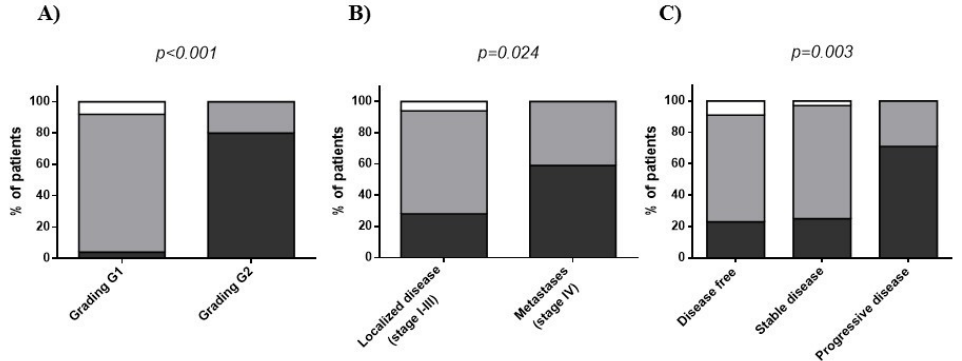
Figure 2. Adherence to the Mediterranean Diet according to PREDIMED categories in GEP-NET patients classified by tumor grade G1/G2 ( A ), stage ( B ), and disease status ( C ). Abbreviation: GEP-NET, Gastroenteropancreatic Neuroendocrine Tumor; PREDIMED, PREvención con DIeta MEDiterránea; MD, Mediterranean Diet. Different markers, such as grading, stage, progressive disease, ki67% index, and tumor size, were evaluated to investigate tumor